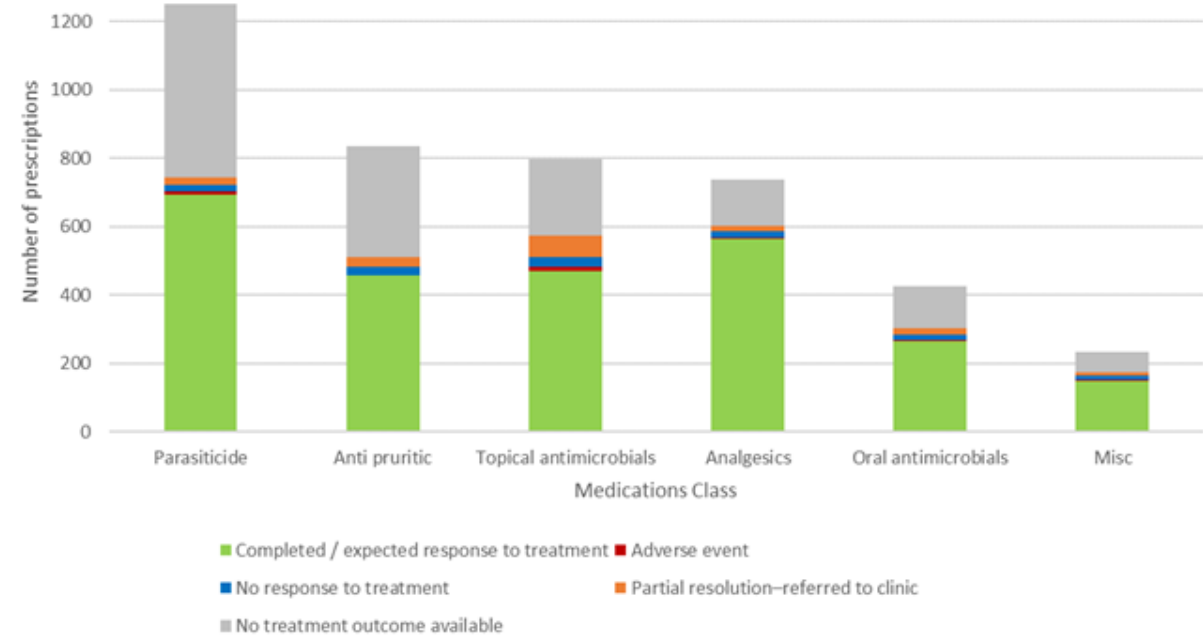
Figure 8: Patient outcomes for remote POM-V / POM prescriptions for the audit period grouped by medication